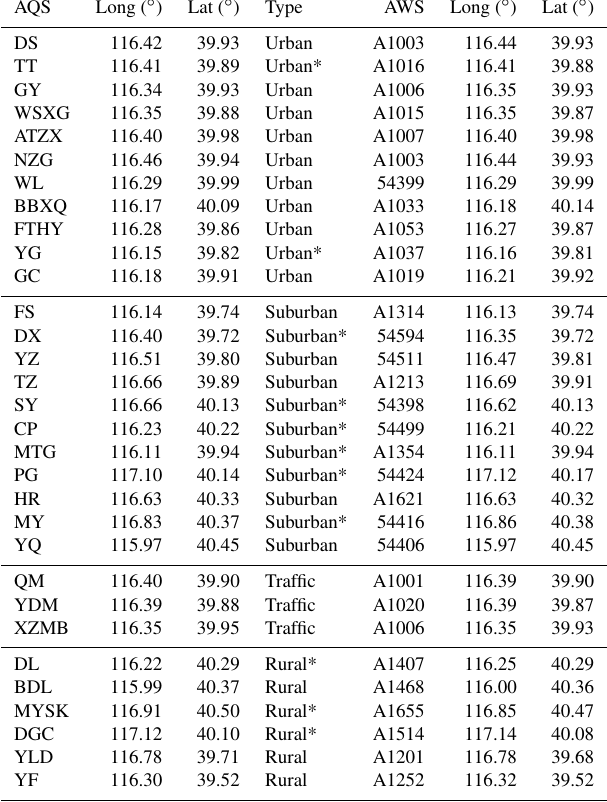
Table 1. The location information and station type of AQSs; the corresponding AWSs are the closest matching weather station among 295